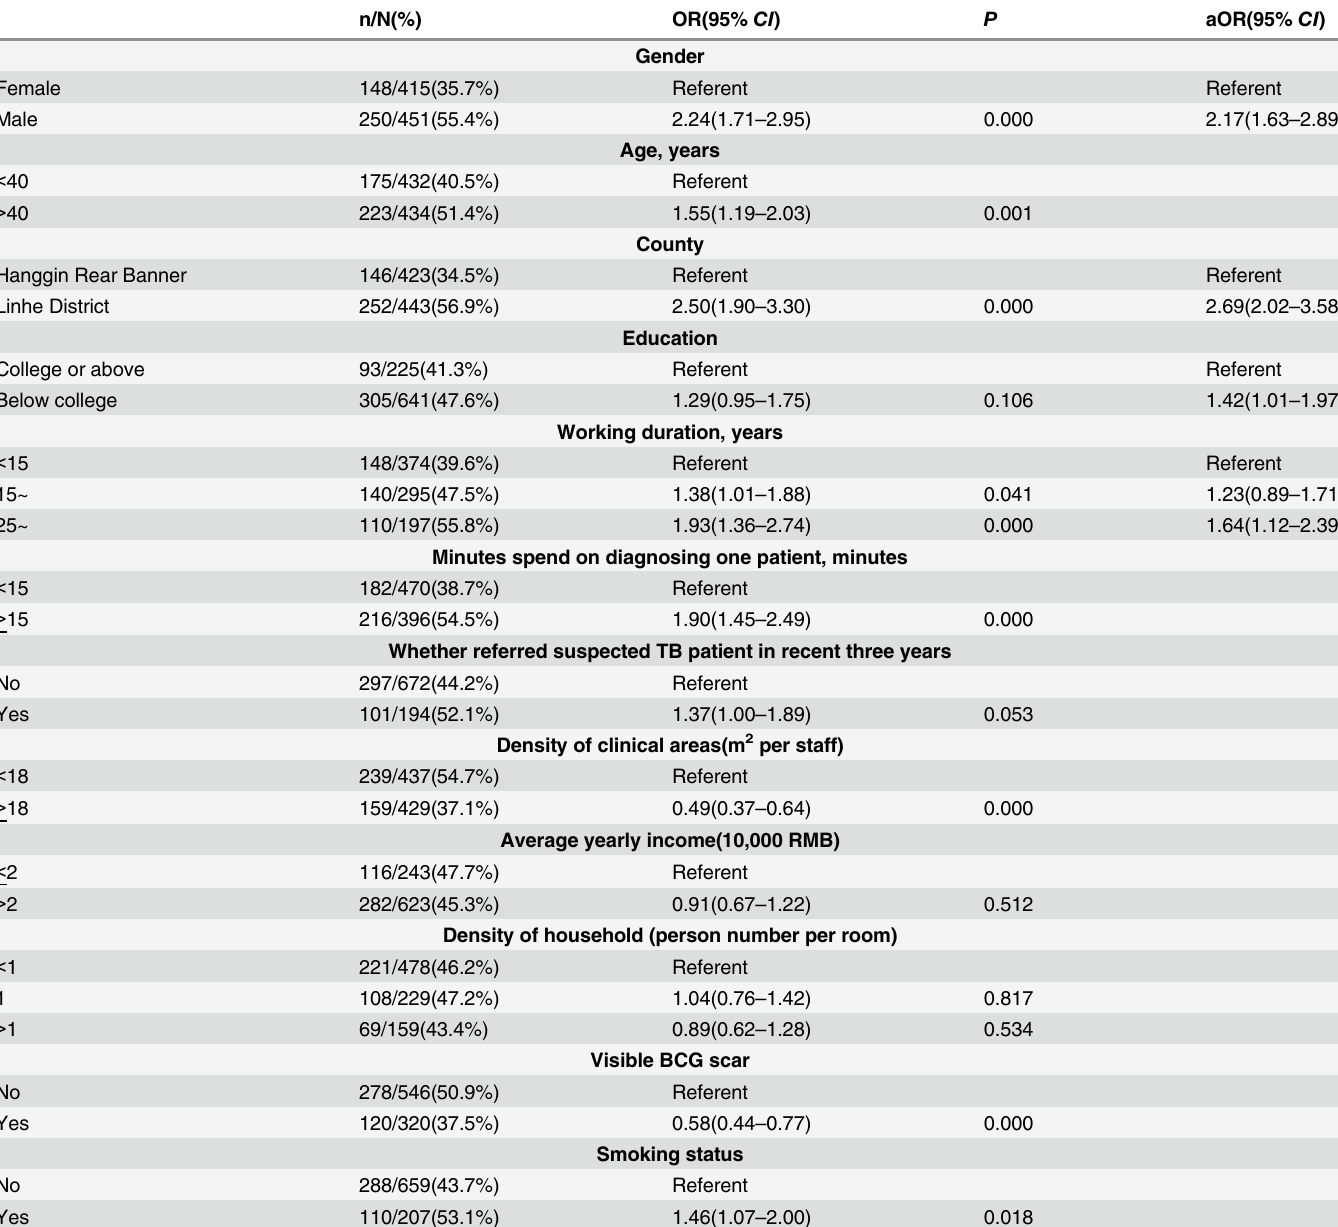
Table 3. The prevalence of LTBI detected by QFT-GIT and its associated factors among village doctors in